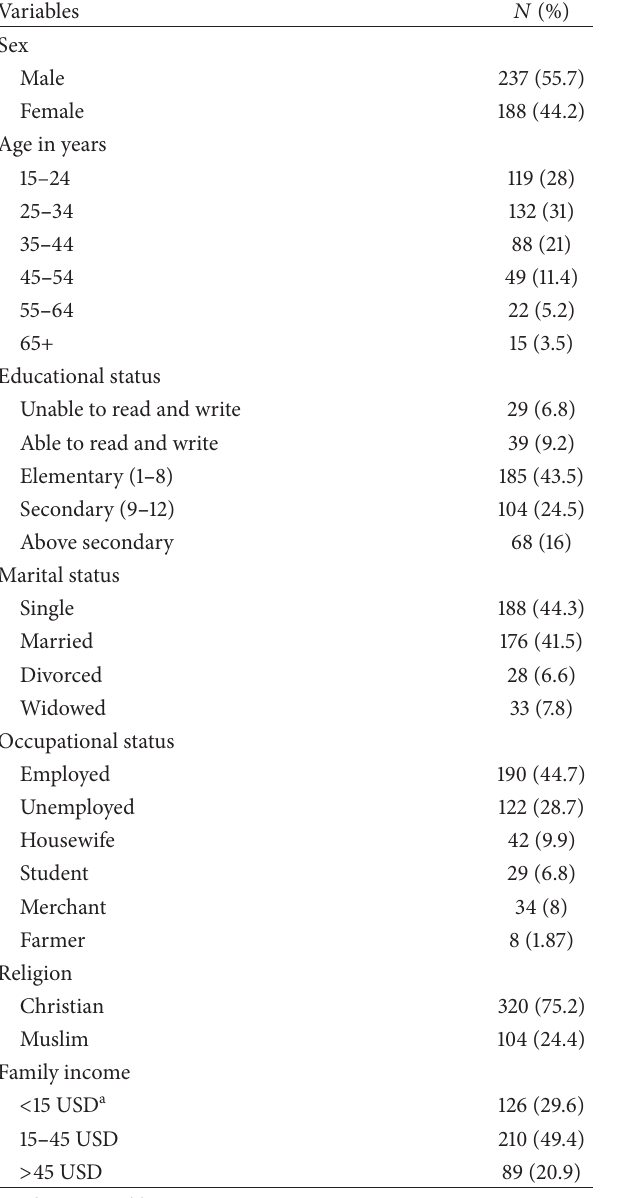
Table 1: Sociodemographic characteristics of pulmonary TB patients, Addis Ababa, Ethiopia, 2012.